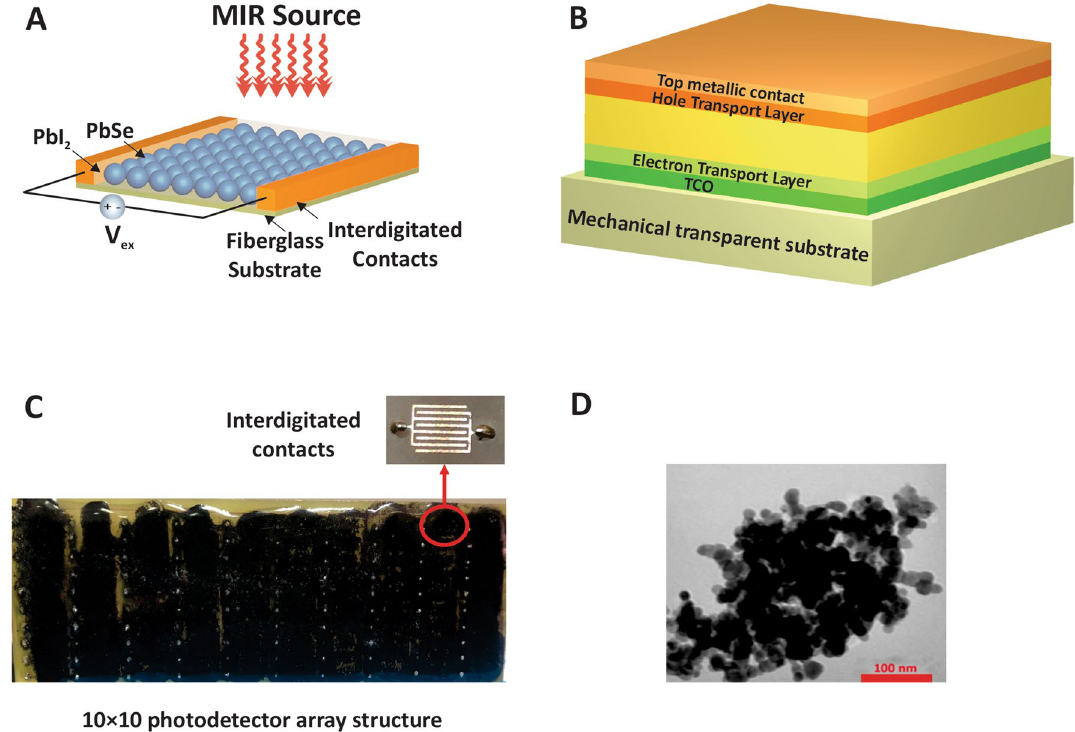
Figure 1. Schematic illustration of MIR-to-visible light upconversion device. Structure of the analyzed infrared detectors in ( A ) planar and ( B ) vertical geometry model 32 . ( C ) Real image of the fabricated photodetector array structure. ( D ) TEM image of synthesized PbSe/PbI 2 nanoparticles 31 .